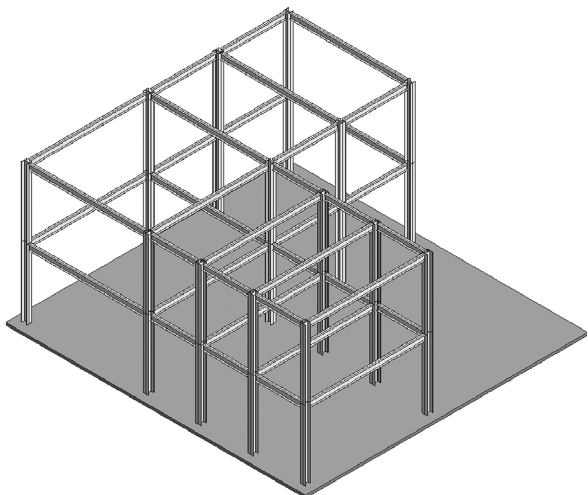
Figure 5: A sample BIM model for a steel structure frame.